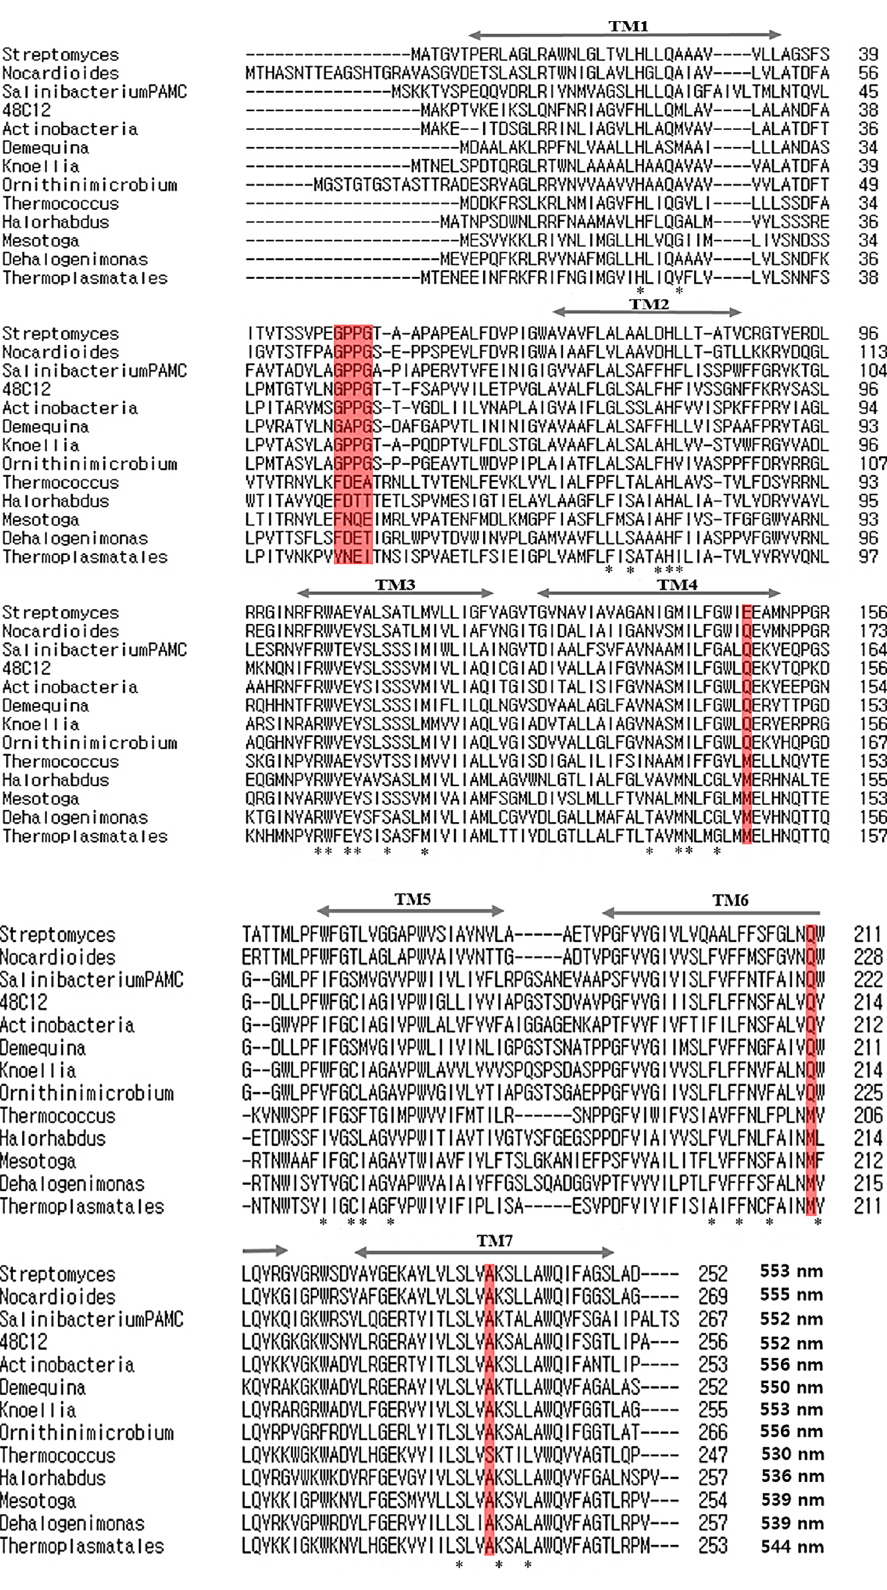
Figure 2. Sequence alignment of 13 heliorhodopsin sequences. Four heliorhodopsins have an absorption maximum < 540 nm, one heliorhodopsin has an absorption maximum at 544 nm, and the other heliorhodopsins have absorption maxima > 550 nm. Significantly different amino acid regions are marked in red. The asterisk (*) indicates residues that comprise the retinal binding pocket 24